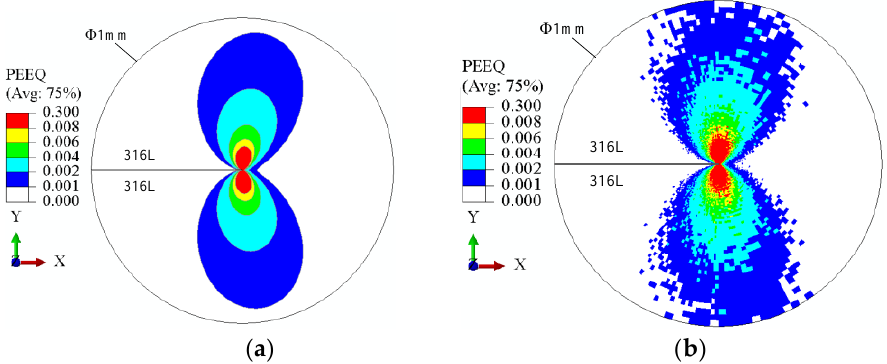
Figure 11. Equivalent plastic strain at the tip of crack 3: ( a ) homogeneous, ( b ) inhomogeneous.